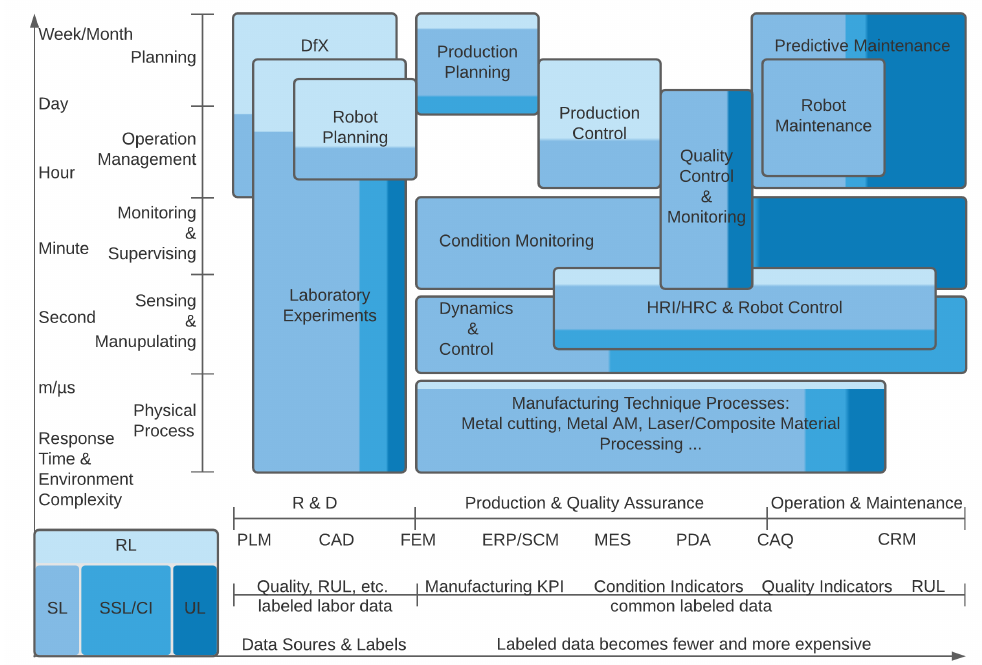
Figure 9. An illustration of AI-integration in multiscale/fidelity DTs along the product